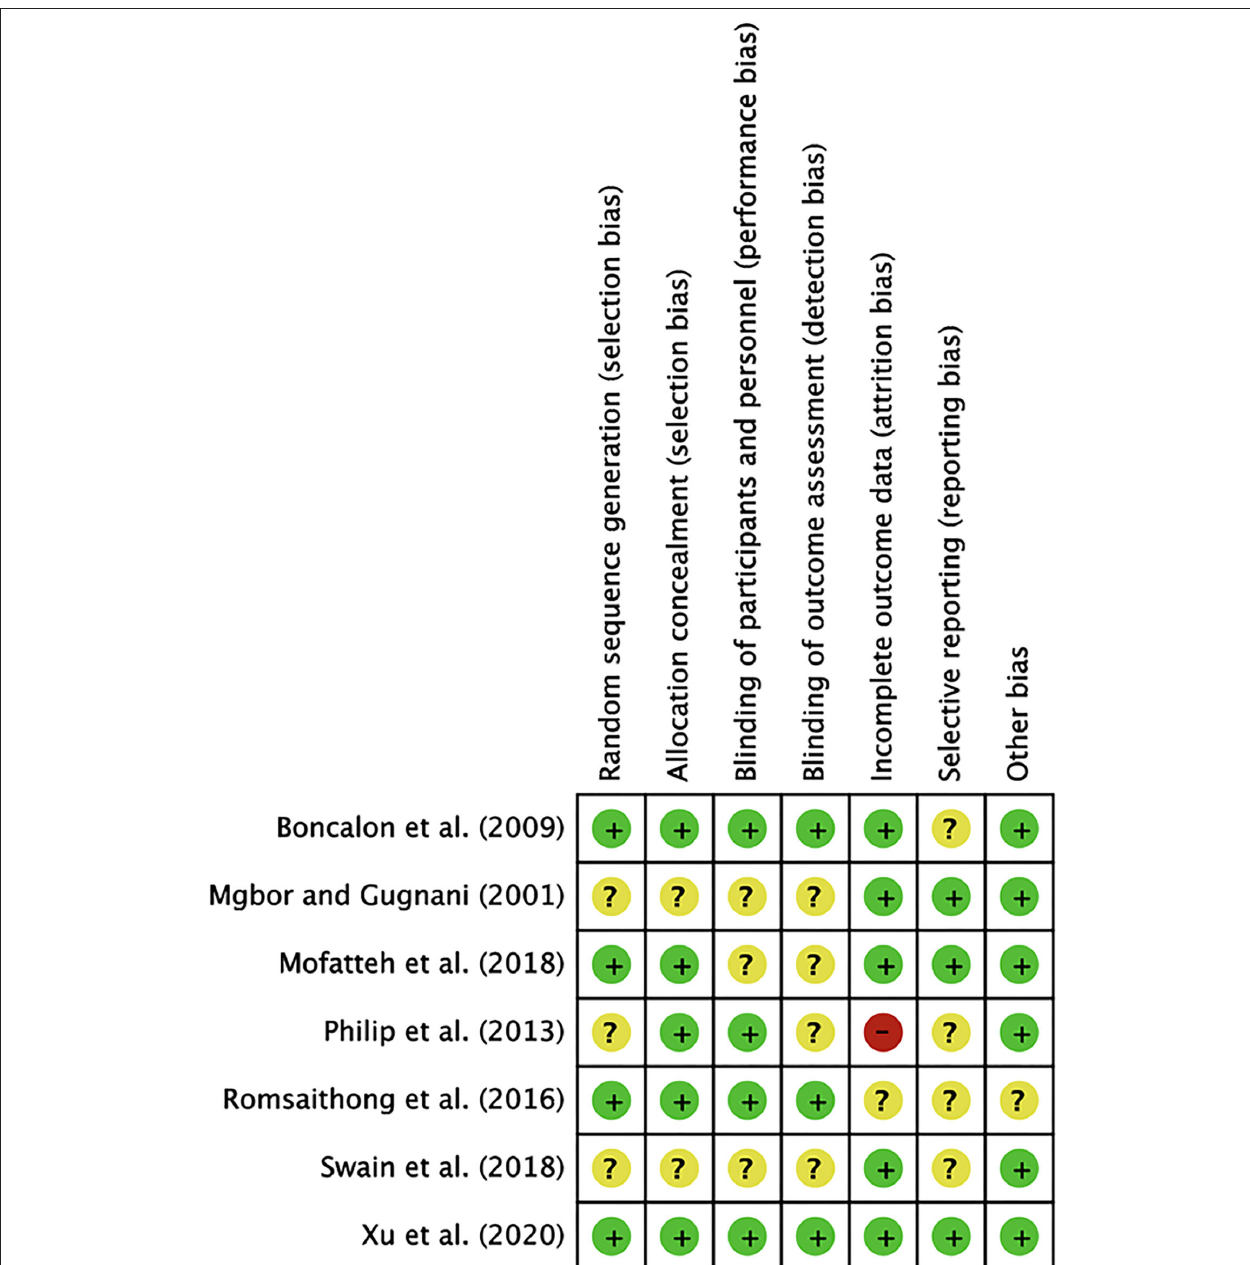
FIGURE 3 | Findings of the risk of bias evaluation. Findings of the risk of bias evaluations using the Cochrane Scale are shown. Green, low risk of bias; red, high risk of bias; yellow, unclear risk of bias.